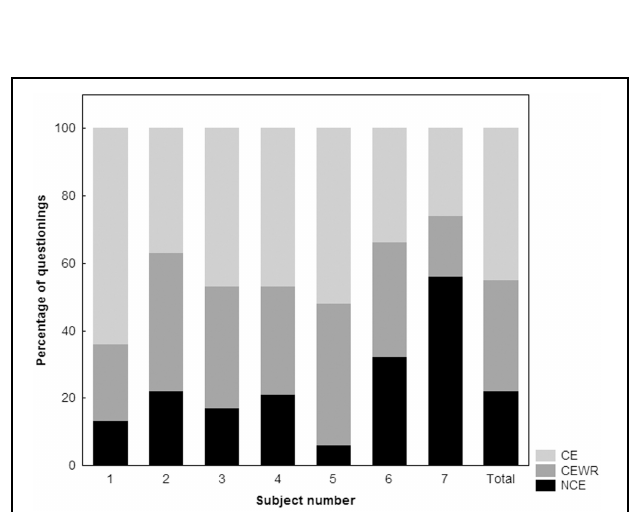
FIGURE 3 | Proportion of conscious experiences (CE), conscious experiences without recall (CEWR) and no conscious experiences (NCE) across